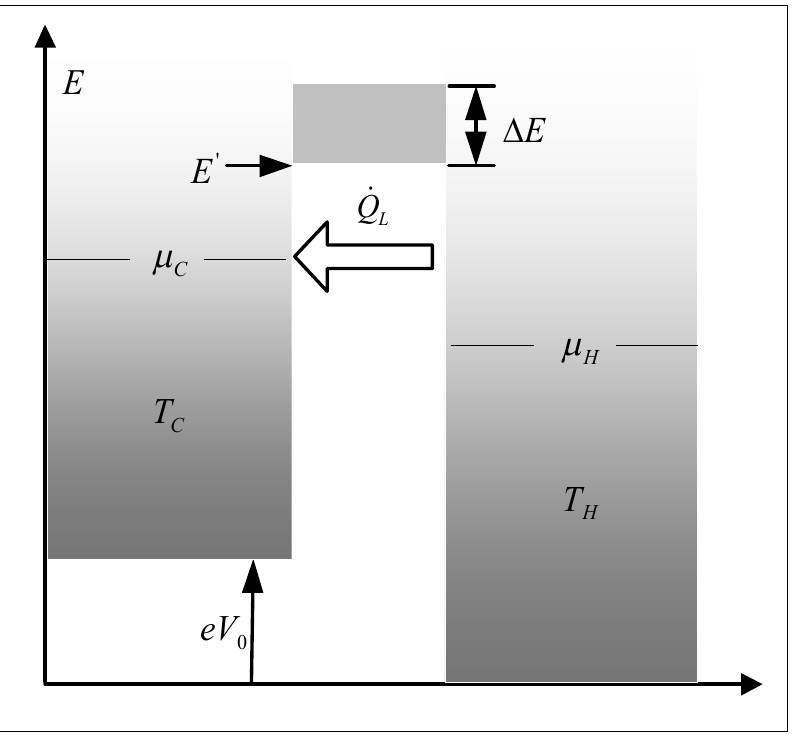
Figure 1. Model of the ESE heat engine [36,39]. Adapted with permission from Ref. [39]. 2016, Junle Zhou, Lingen Chen, Zemin Ding, Fengrui Sun.